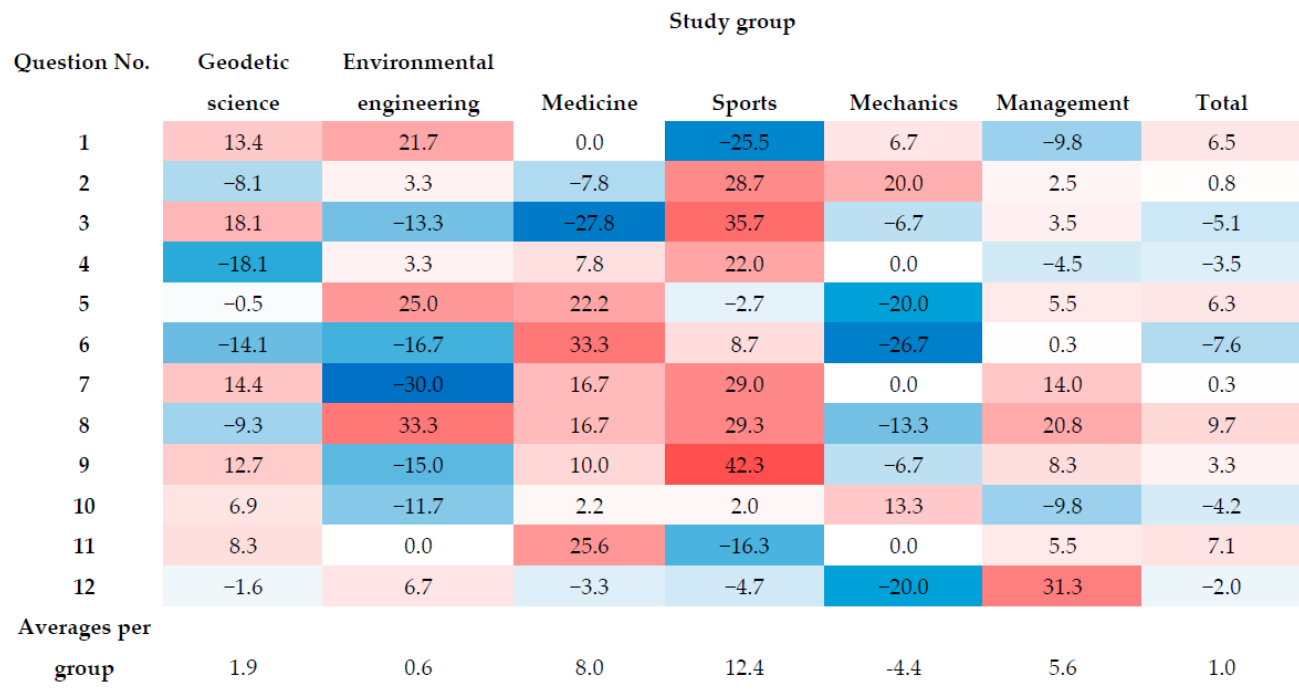
Figure 6. Percentage of correct answers given by women to questions 1 – 12 overall and in the study groups.